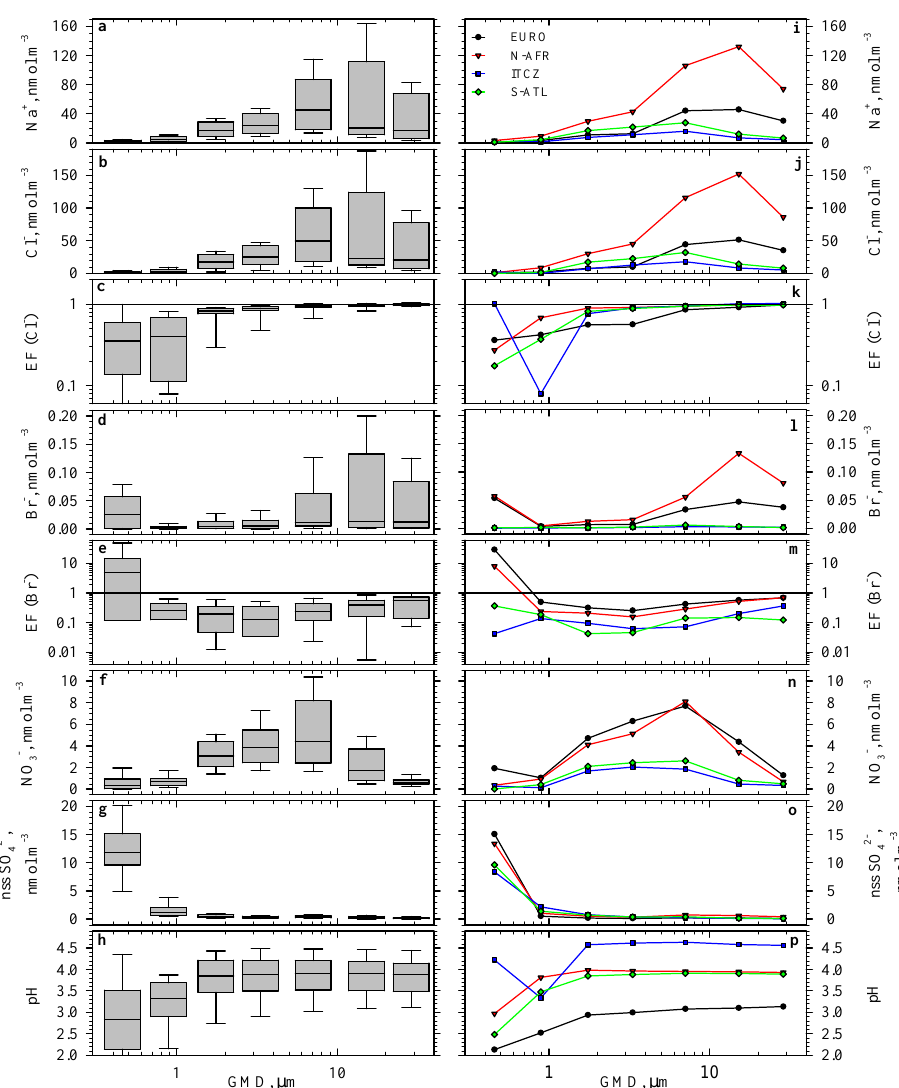
Fig. 3. Left: Box and whisker plots depicting measured and directly calculated particle size distributions (90th, 75th, 50th, 25th, and 10th percentiles) based on all data for (a) Na+, (b) Cl − , (c) EF(Cl-), (d) Br − , (e) EF(Br − ), (f) NO − from the measured HCl phase partitioning. Right: Corresponding median size distributions of (i) Na + , (j) Cl − , (k) EF(Cl − ), (l) Br − , (m) EF(Br − ), (n) NO − , (o) nss SO 2 − , and (p) aerosol pH for each transport 3 4